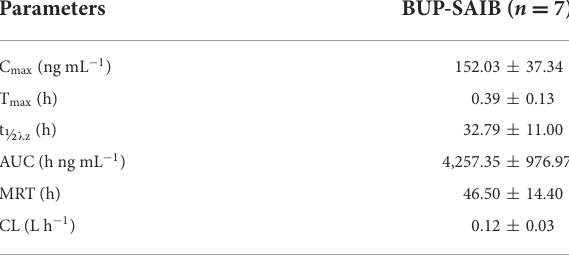
TABLE 2 Pharmacokinetic parameters (mean ± SD) of bupivacaine following cornual nerve block using BUP-SAIB formulation (5mL per side) in calves ( n =